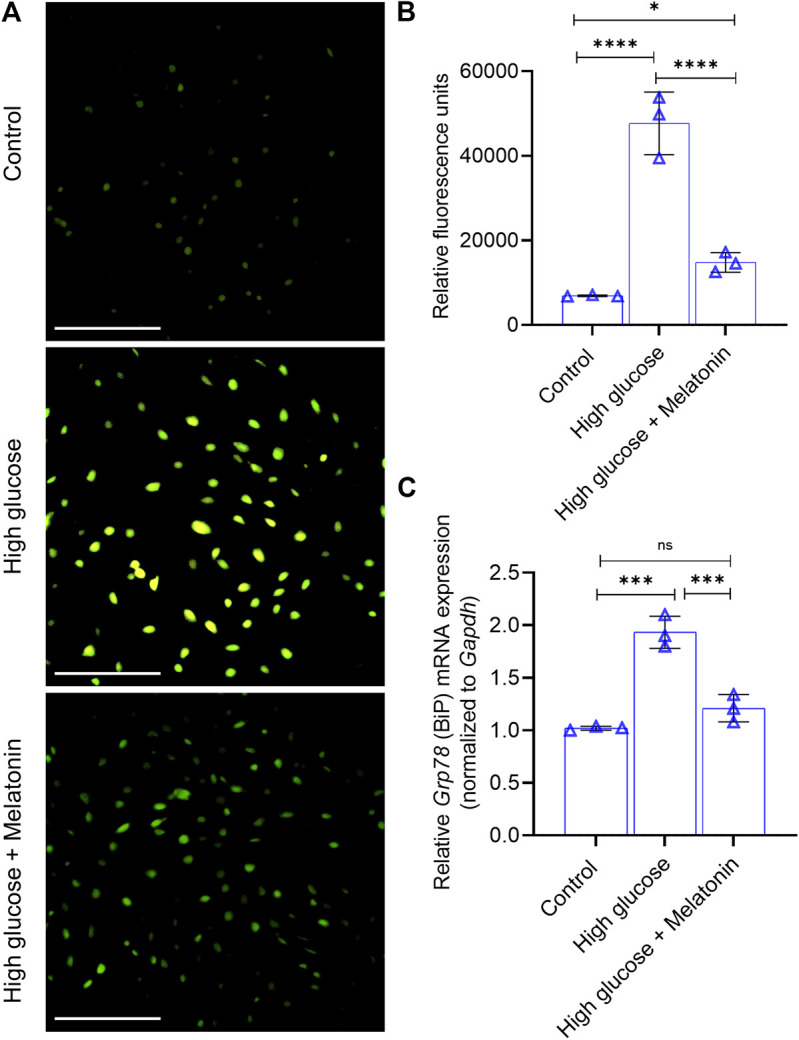
Melatonin alleviates high glucose-induced ER stress (A,B) Analysis of Ca2
+ influx in the MC3T3-E1 cells grown under normal (control) and high glucose conditions for 48 h ± melatonin (100 nM) is shown using the (A) representative images obtained from Fluo-4 imaging (Scale bar: 50 µm) and (B) quantified spectrophotometrically using Fluo-4/AM (C) Relative mRNA expression of Grp78 (which encodes BiP) is shown as indicated. The fold expression was calculated relative to the expression under control conditions. Gapdh was used as a normalization control. For (B,C), bars are mean ± SEM. *p < 0.05, ***p < 0.001, ****p < 0.0001, ns, not significant.